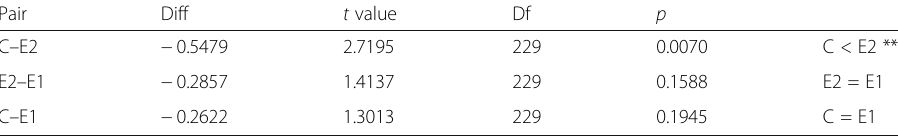
Table 15 Holm ’ s sequentially rejective Bonferroni procedure results for Material 2 Pair Diff t value Df p −